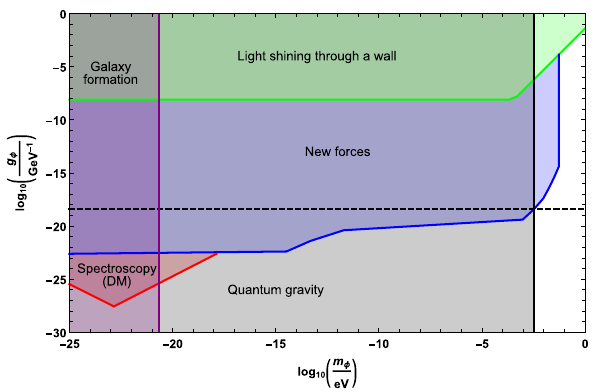
Fig. 1 Limits on the linearscalar interaction g φ = c 1 /(cid:4) 1 as a function of the mass of the scalar m φ . Green: limits from light shining through a wall experiments [46,47]. Blue: limits from torsion experiments [34– 42].Red:limitsfromatomicspectroscopyexperiments[43–45].Purple: limits from galaxy formation, quasar lensing and stellar streams [48– 53]. Black: limits from quantum gravity as discussed in this paper. Dashed black line: reduced Planck scale